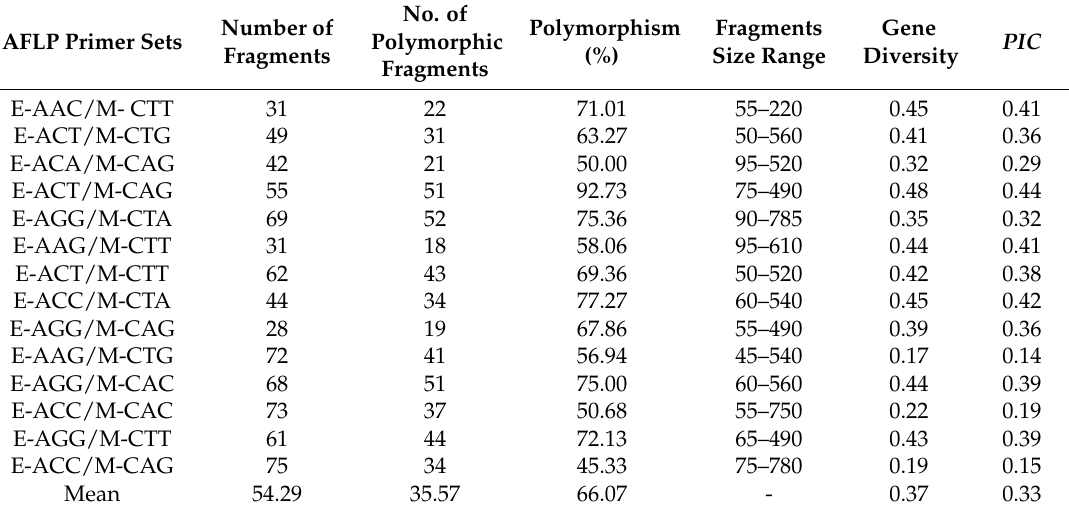
Table 1. AFLP primers, fragments number and genetic variability indices in the 40 barely varieties.